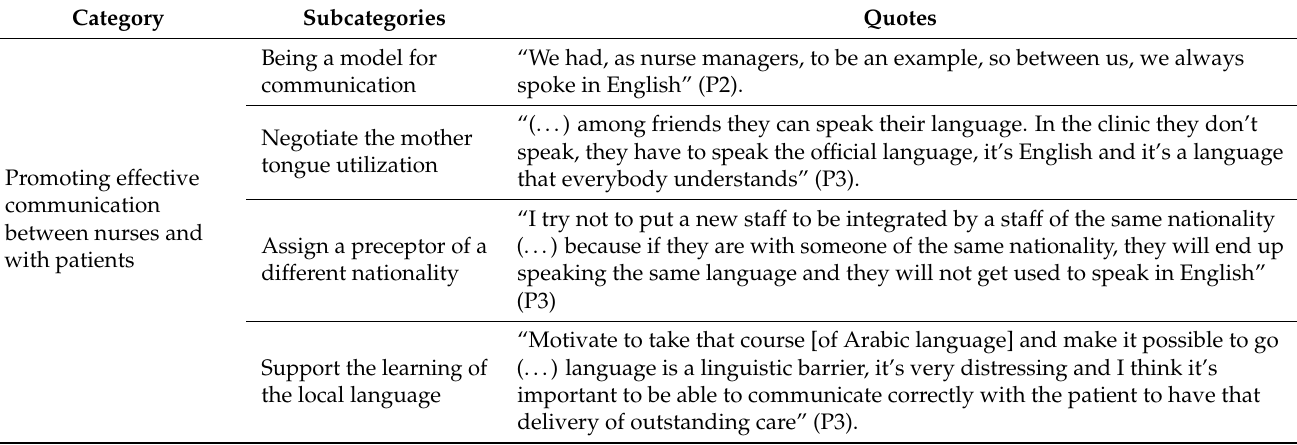
Table 5. Subcategories of the “Promoting effective communication between nurses and with patients” category and participants’